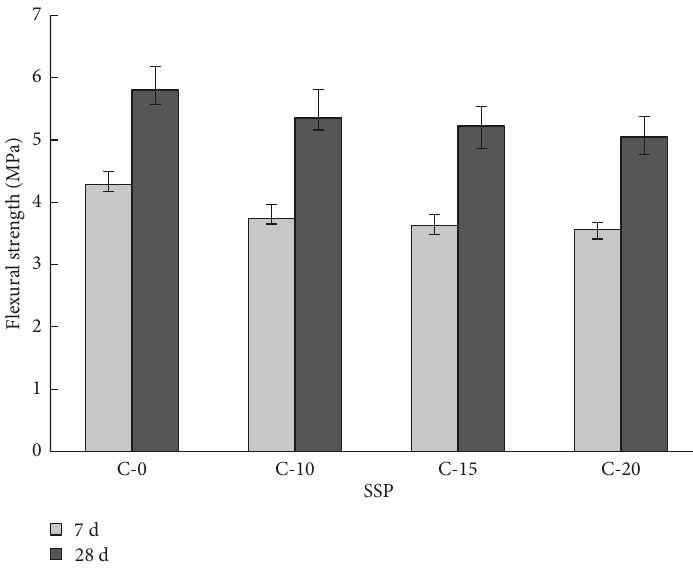
Figure 12: The flexural strength.